Question: According to this chart, does the measure grow or shrink?
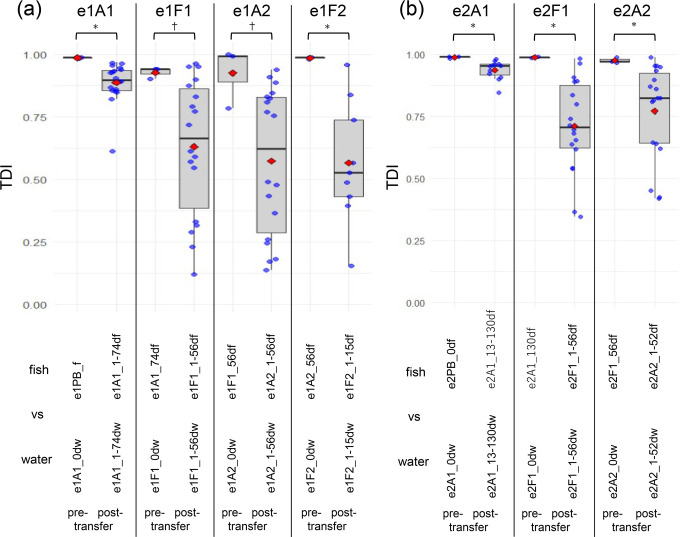
Answer: decreasing